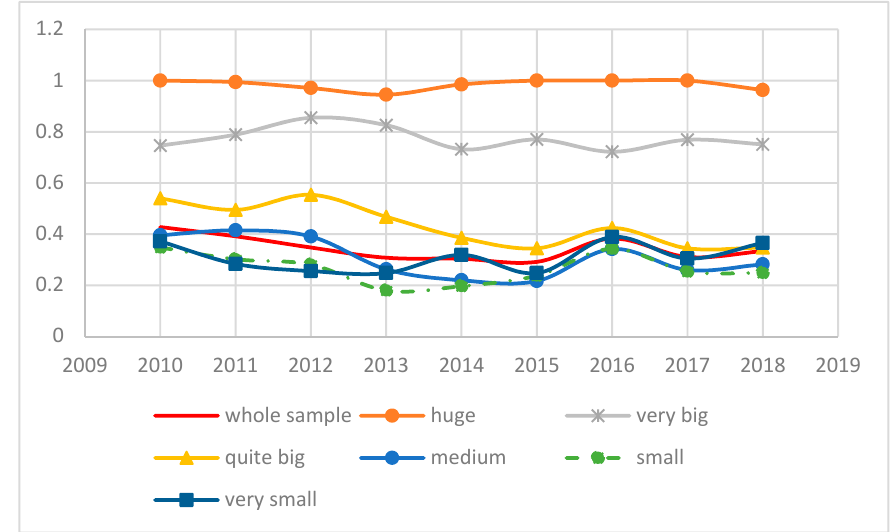
Figure 4. Average efficiency, pharma and biotechnological industry by size, 2010–2018. Note: the figure summarizes the yearly trend of average efficiency of the firms in our sample, disaggregated by size of firms. Size is proxied by real turnover. Efficiency decreases over the period for all categories except for the huge and very big firms. The thresholds are detailed in the main text. Source: own elaboration.